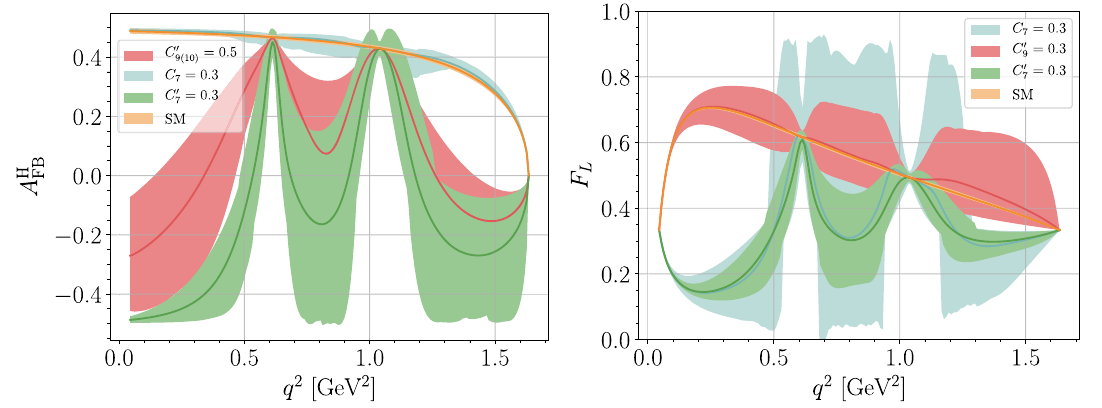
= 0 . 5 and C (cid:3) = 0 . 3 in blue, red and 9 7 ( (cid:3) ) can not be distinguished 10